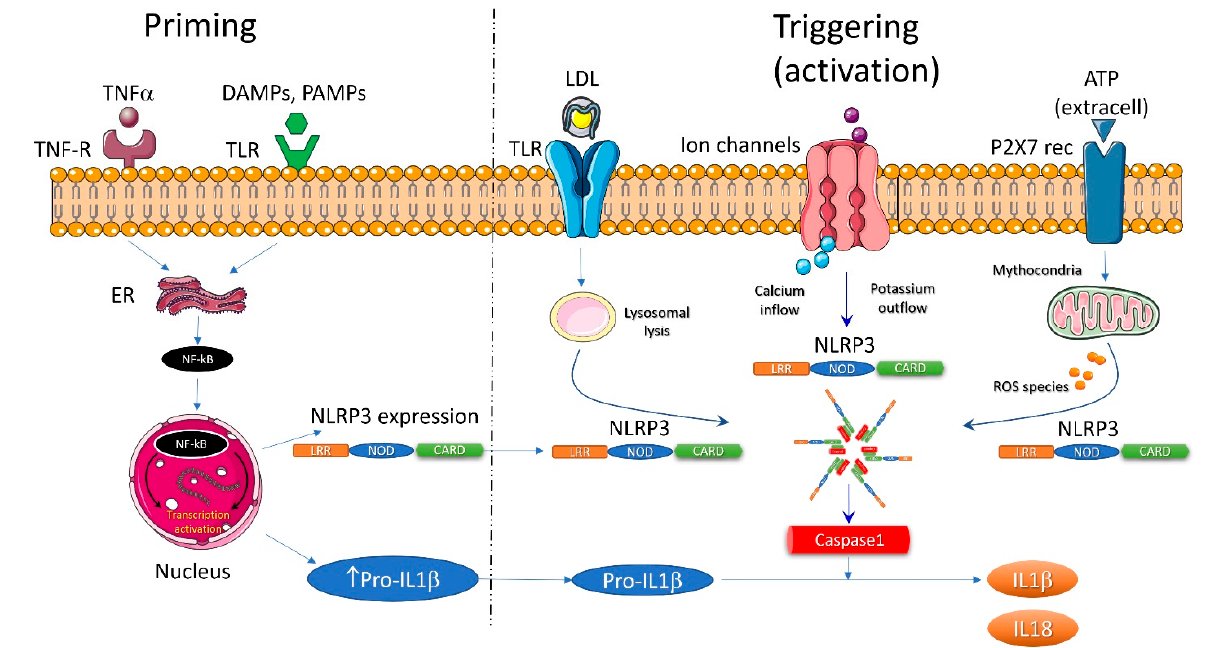
Figure 3. The two main steps for full inflammasome activation. Initiation of the process is priming, which leads to increased expression of NLRP3 and pro-IL-1b via nuclear factor-kappa B. This acts as a second messenger for toll-like receptor activation via DAMPs or PAMPs; an alternative pathway is NF-kB stimulation by TNF receptor and TNF α . Triggering or full activation of the inflammasome is the final oligomerization of NLRP3 with procaspase-1 cleaving properties. It can be induced by intracellular signaling due to increased ROS generation by dysfunctional mitochondria, potassium efflux or calcium influx, or lysosomal lysis after LDL crystal endocytosis. (Reproduced with permission, [31])